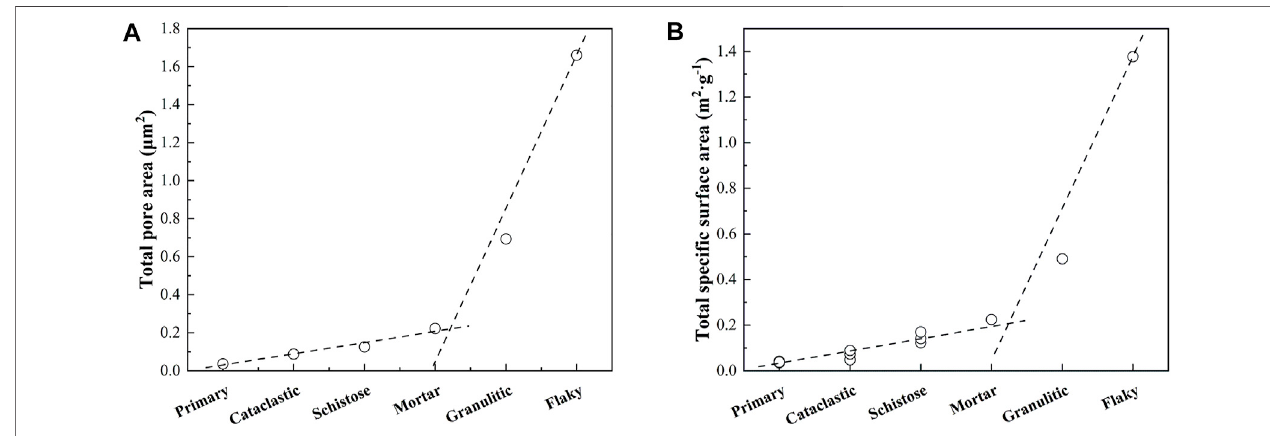
FIGURE9|(A) Totalporesurfaceareafrom AFMinthisstudy; (B) TotalSpeci fi csurfaceareafromLTN 2 AinJuetal. ’ sstudies(Juet al.,2005a;Juetal.,2005b;Ju and Li 2009).